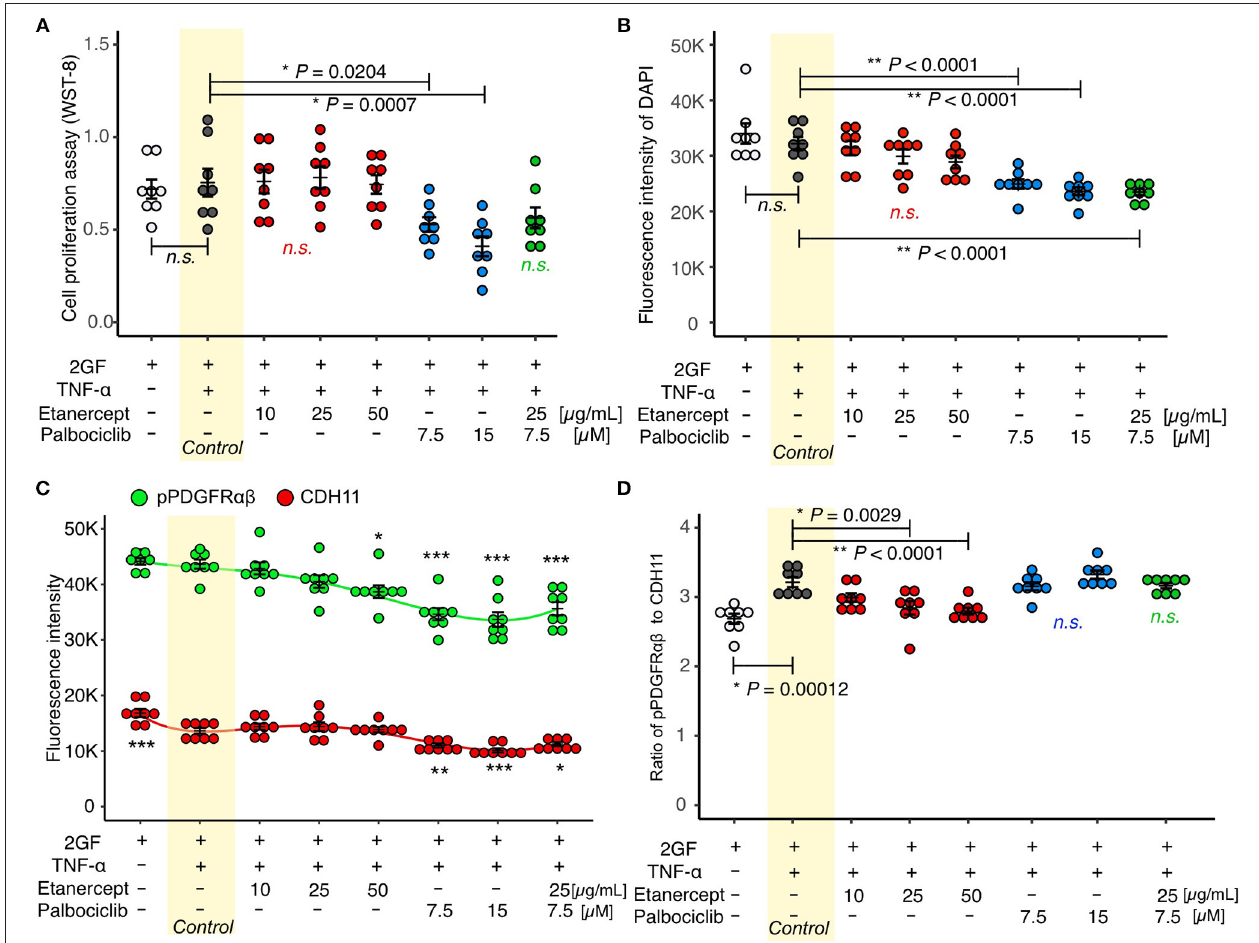
FIGURE 7 | Etanercept suppressed pPDGFR αβ expression in RA-FLSs stimulated with 2GF + TNF, and palbociclib reduced the cell count. (A) cell proliferation assay and (B–D) quantitative cell count and pPDGFR αβ /CDH11 ratio data obtained by performing in-cell ELISAs with FLSs stimulated with 2GF + TNF and exposed to different concentrations of etanercept and palbociclib. Adding etanercept to FLSs stimulated with 2GF + TNF did not significantly decrease the number of live cells, but significantly reduced the pPDGFR αβ /CDH11 ratio. Adding palbociclib significantly reduced the number of live cells, but did not significantly change the pPDGFR αβ /CDH11 ratio. Etanercept + palbociclib significantly reduced the number of live cells, but did not significantly change the pPDGFR αβ /CDH11 ratio. Dunnett’s test was used to statistically analyze differences occurring with 2GF + TNF stimulation. The significance level was P < 0.05. * P < 0.05; ** P < 0.01; *** P <